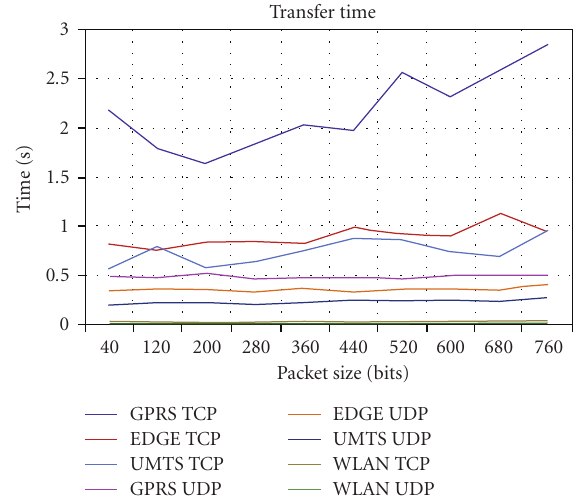
Figure 7: Measured transfer